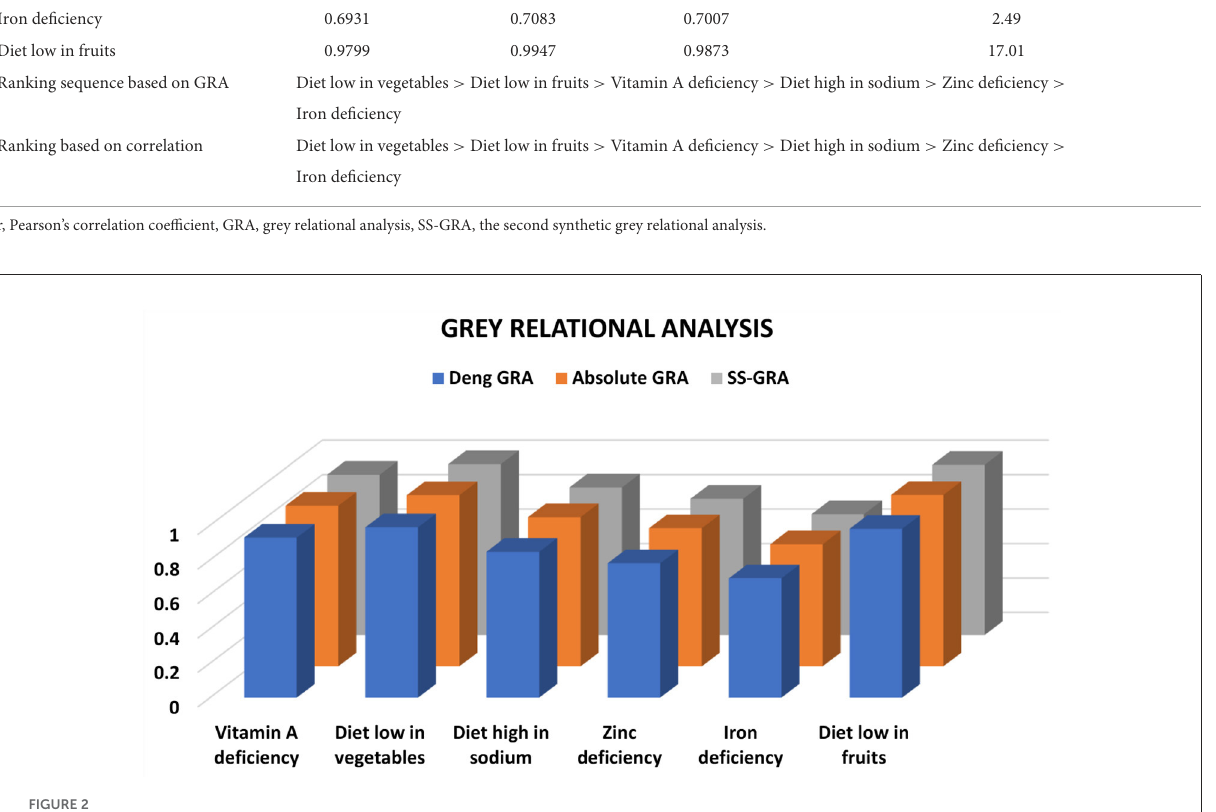
FIGURE2 GRA assessment between IHD and nutritional